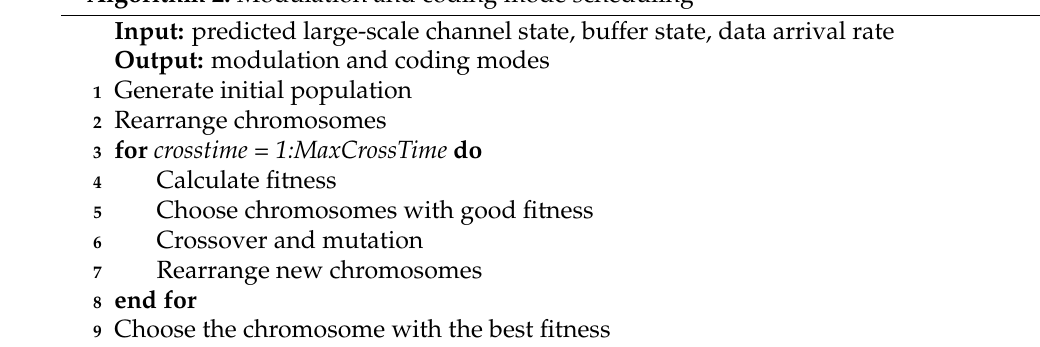
Algorithm 2: Modulation and coding mode